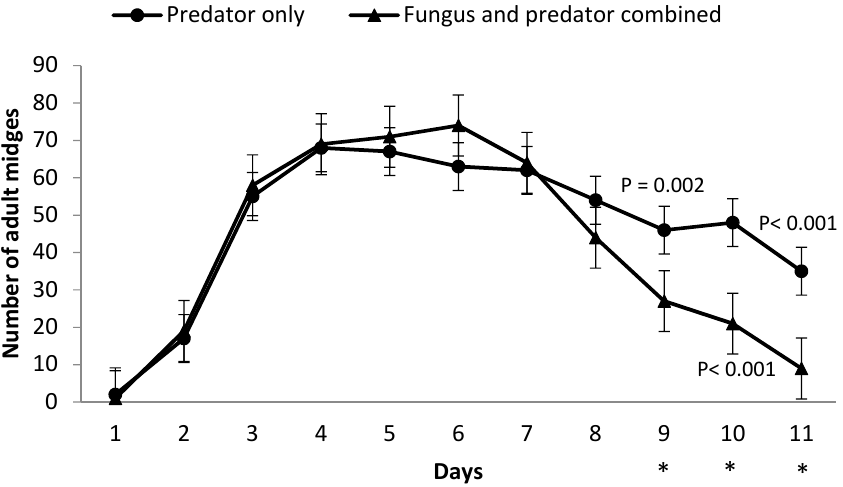
Figure 2. Daily numbers of A. aphidimyza midges in the absence (predator only treatment) or presence (fungus and predator combined treatment) of M. brunneum from first day of emergence until last day of experiment. Asterisks indicate statistically significant ( p < 0.05) differences among treatments.